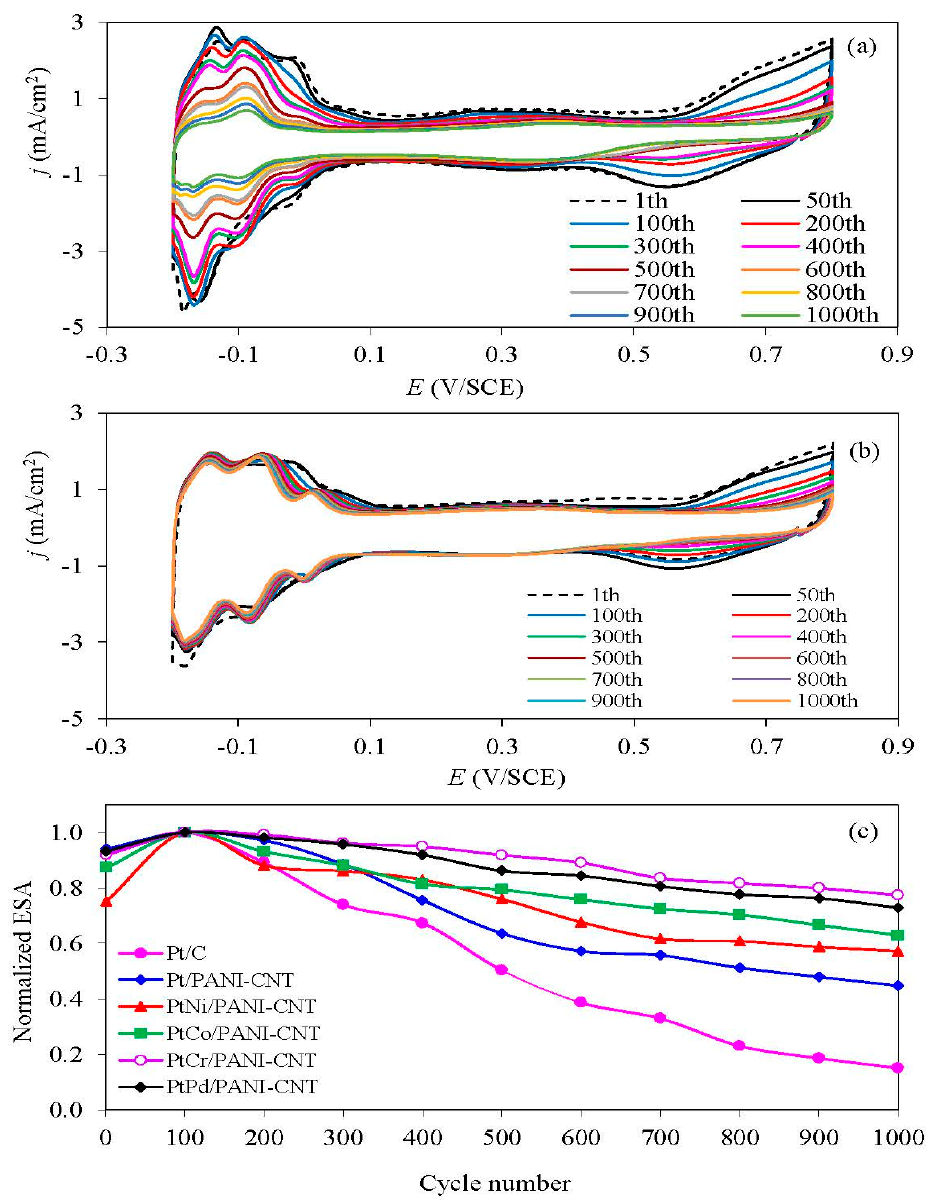
Figure 9. Representative of repetitive CV of: ( a ) Pt/C and ( b ) PtPd/PANI-CNT; and ( c ) the normalized